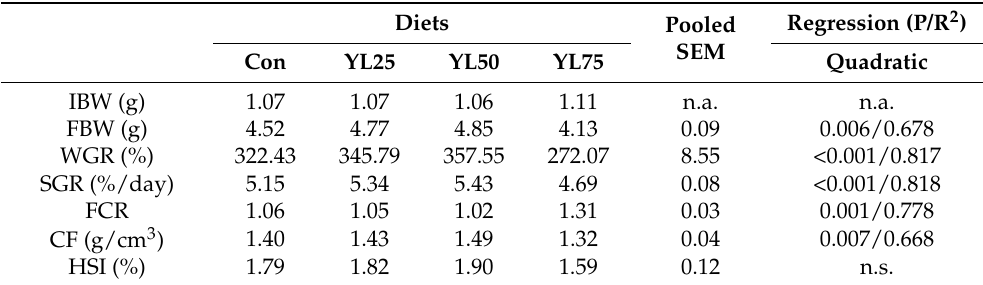
Table 1. Growth performance and feed utilization of largemouth bass fed the experimental diets for 28 days *.